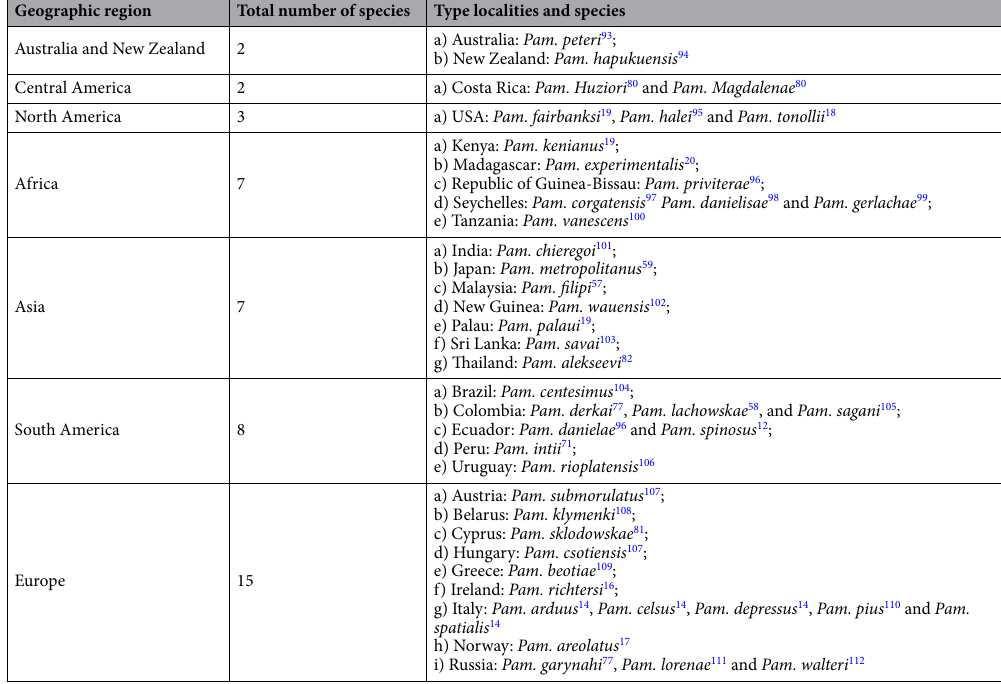
Table 4. Type localities of all known Paramacrobiotus